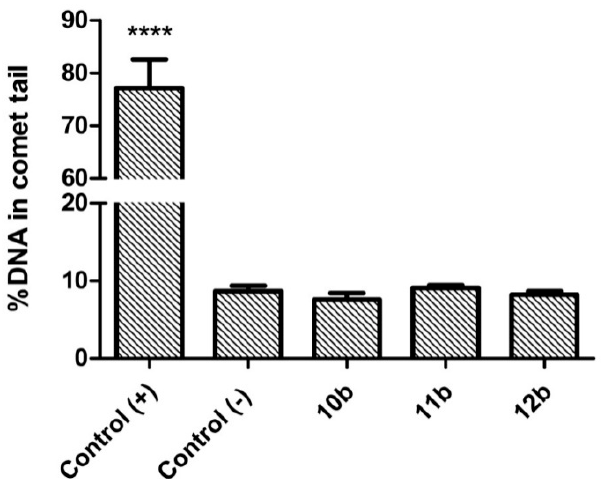
Figure 6. Quantitative analysis of the DNA damage in Hs27 cells after 24 h exposition to cisplatin (positive control, 10 µg/mL) or the thiadiazoles 10b – 12b . Data are shown as mean ± SEM. Statisti-